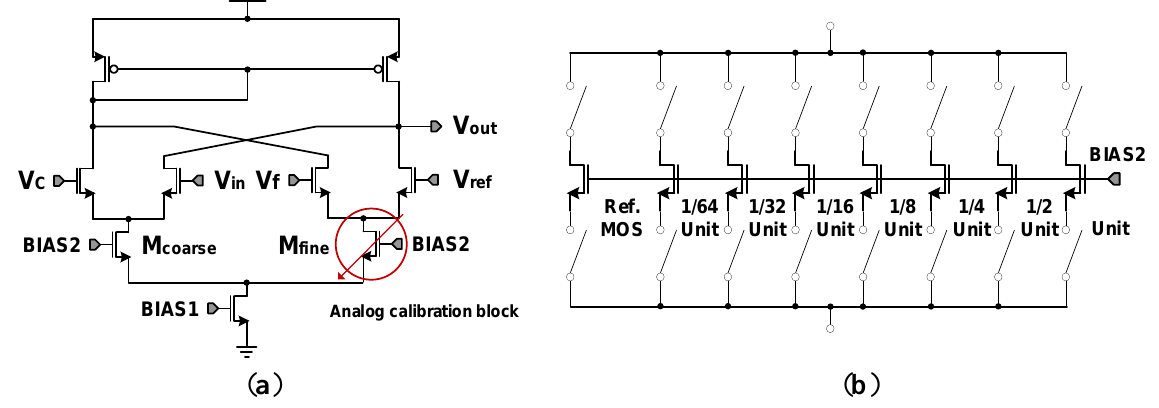
Figure 9. Circuit diagram of the self-calibration technique: ( a ) circuit diagram of 4-input comparator; ( b ) magnified circuit diagram for M